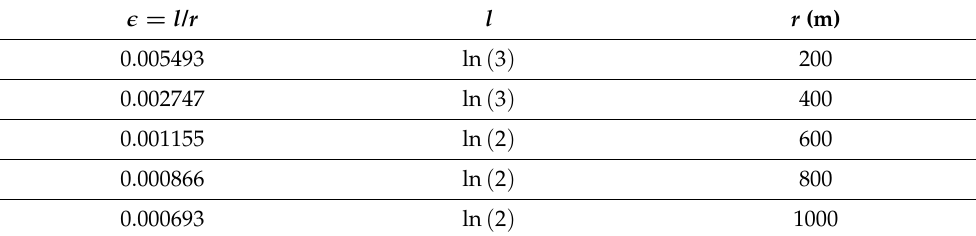
Table 2. Values of (cid:101) = l / r for sanitizing emergency location data with GI. (cid:101) = l / r l r